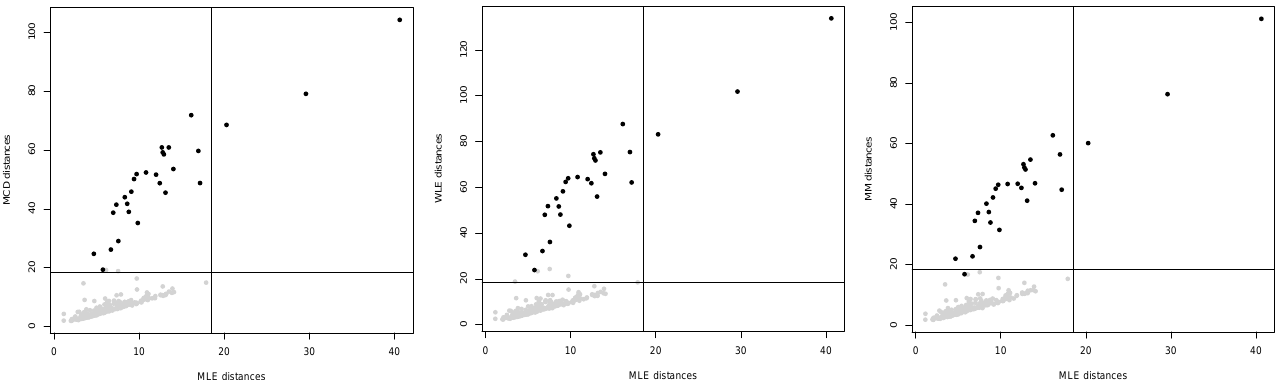
Figure 10. RNA data. Distance-distance plot stemming from the reweighted MCD, WLE, and MM-estimation. Points from cluster 23 are in black. The horizontal and vertical lines give the χ 2 7;0.99